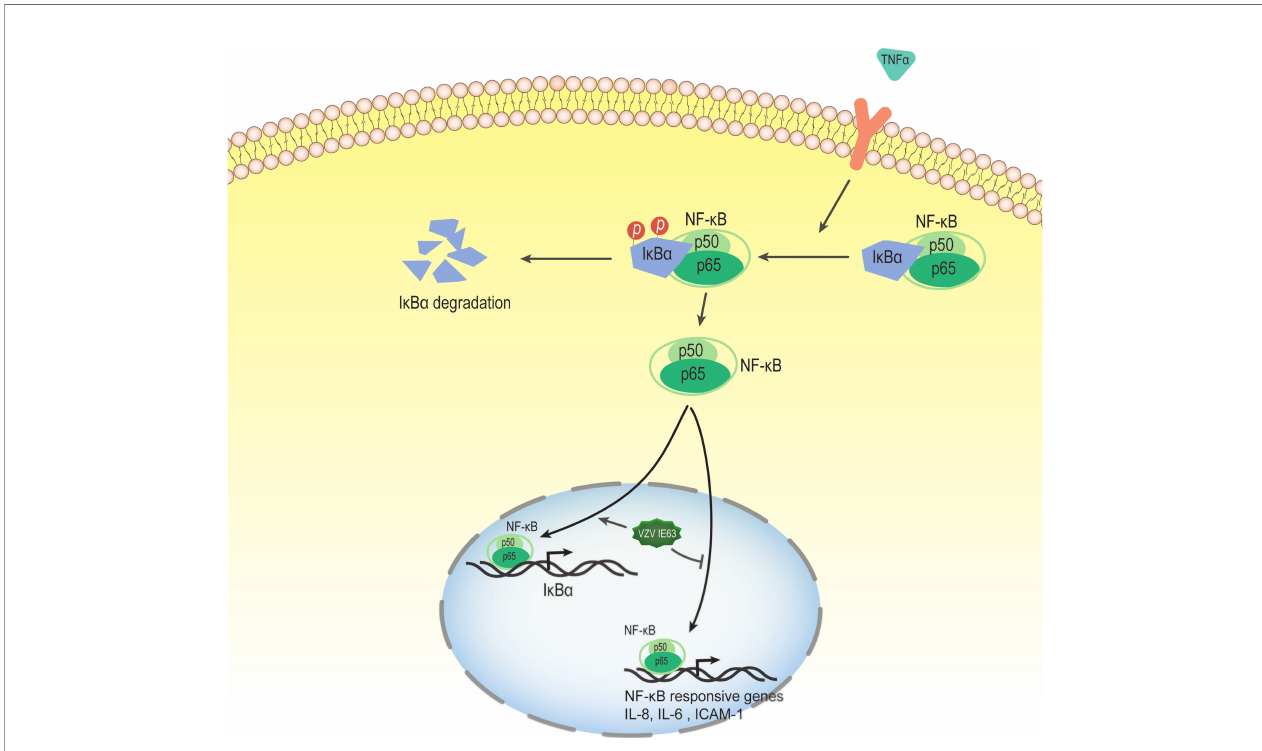
FIGURE 7 | VZV IE63 modulates proin fl ammatory gene transcription by inhibiting the NF-KB pathway. The activation of NF- k B signaling is caused by extracellular stimulation. These stimuli are recognized by the receptor and delivered to the cell, which ultimately leads to the activation of I k B kinase (IKK). IKK phosphorylates inhibitory I k B in the cytoplasm and this causes I k B to be degraded by the proteasome and releases NF- k B from the inhibitory complex. The released NF- k B protein is then transported to the nucleus, where it binds to the target sequence DNA and activates gene transcription. After treating HeLa cells with TNF a , the presence of IE63 reduced the expression of IL-8, IL-6 and ICAM-1 mediated by TNF a and increased the expression of the I k B a gene. IE63 expressed in TNF a -treated HeLa cells reduced the binding of p65 to the NF- k B proximal sites on the IL-8 and ICAM-1 promoters and enhanced the recruitment of p65 to the I k B a promoter. Treatment of IE63-expressing cells with TNF a inhibits the NF- k B pathway, suggesting that VZV may be a strategy to resist VZV-infected cells from exogenous proin fl ammatory cytokine-induced antiviral